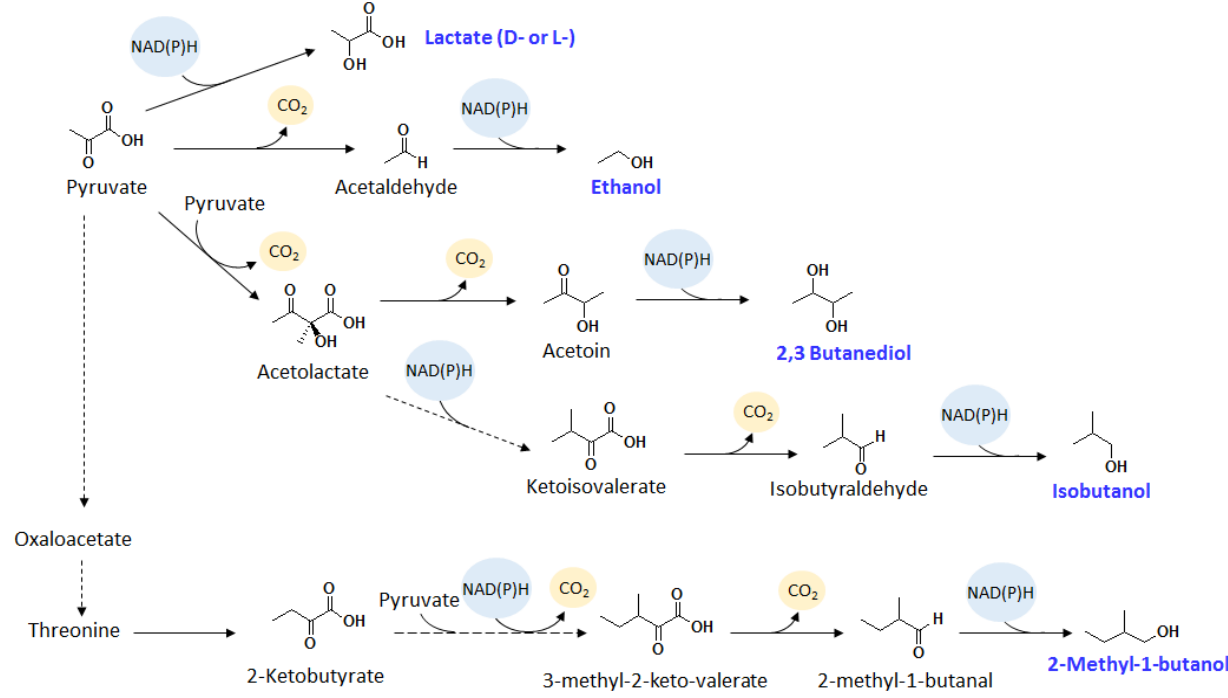
Figure 2. Schematics of pyruvate derived bioproducts. Dashed lines represent multiple enzymatic steps. Evolution of CO 2 serves as effective driving force for product